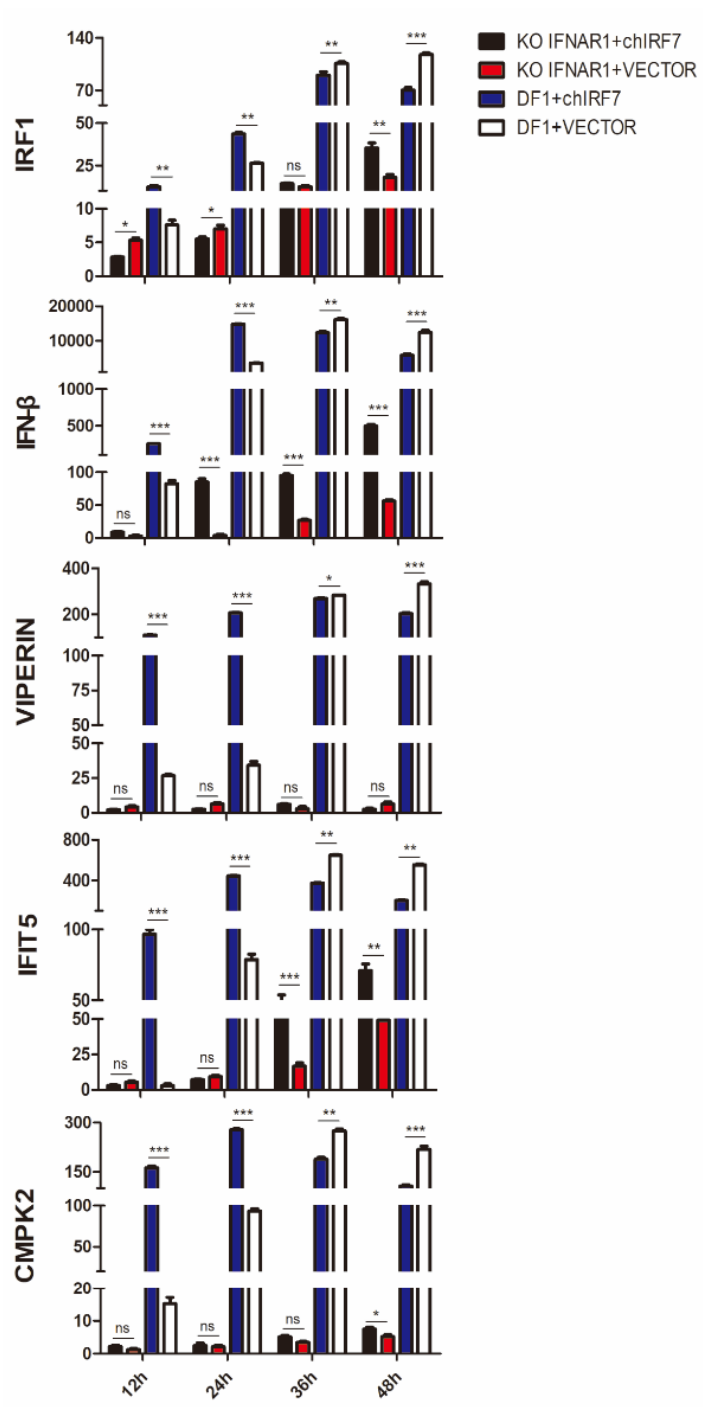
Figure 3. Effects of IRF7-overexpression on the upregulation of IFN- β , IFIT5, VIPERIN, CMPK2, and IRF1 induced by DTMUV in IFNAR1-knockout DF1 cell (KO IFNAR1) . DF1 and KO IFNAR1 cells were transfected with a Flag-tagged chicken IRF7 and infected with DTMUV at an MOI of approximately 2. Cells were harvested at 12, 24, 36, and 48 hpi, respectively. Total RNAs were extracted, and the induction levels of IFN- β , VIPERIN, IFIT5, CMPK2, and IRF1 were determined by RT-qPCR and presented. Error bar represents the standard error of three replicate experiments. T tests were performed between the samples with or without IRF7-overexpression in KO IFNAR1 (red and black) and DF1 cell (blue and slash). (ns, nonsignificant; * p < 0.05; ** p < 0.01; *** p < 0.001 ）